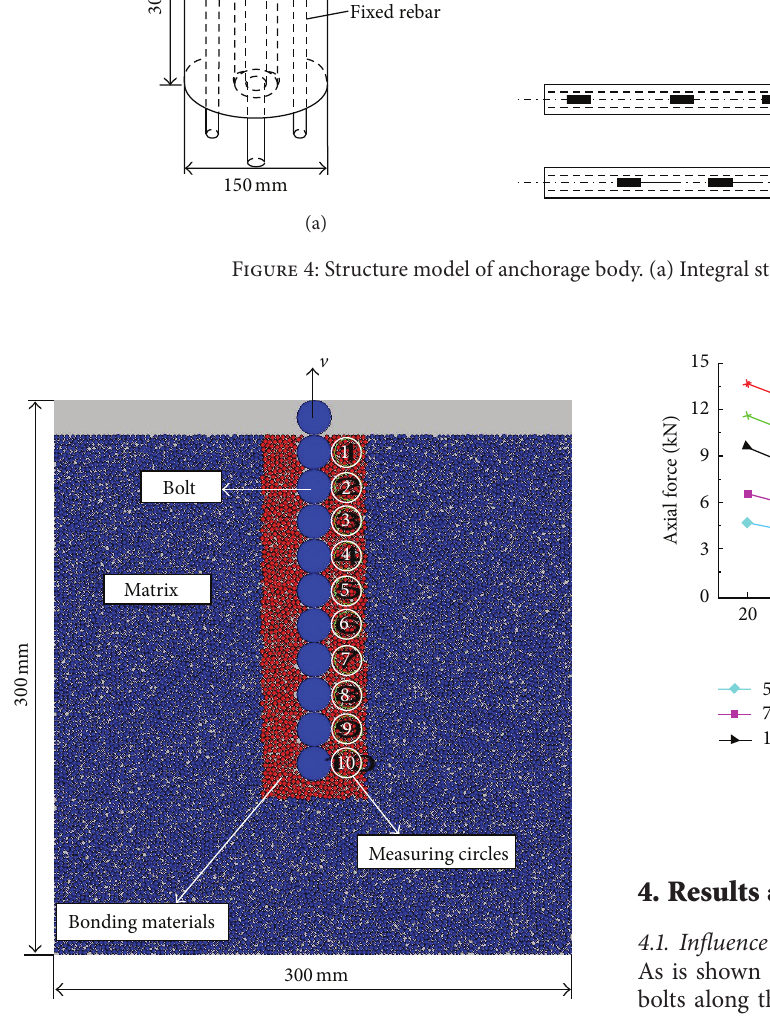
Figure5:Micromechanicalmodelofanchoragebody’spull-outtest. Table 2: Rank classification of strain rates and loading rates [24].